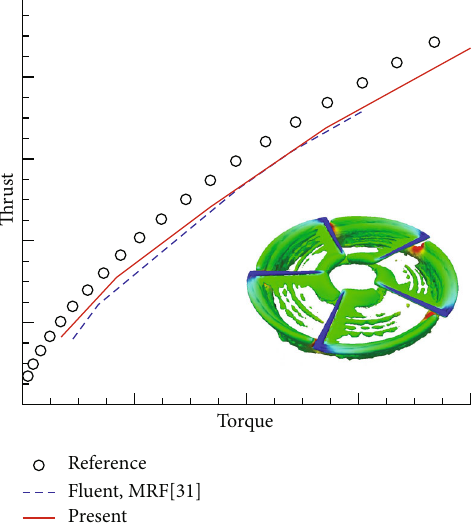
Figure 6: Thrust – torque relationship of the main